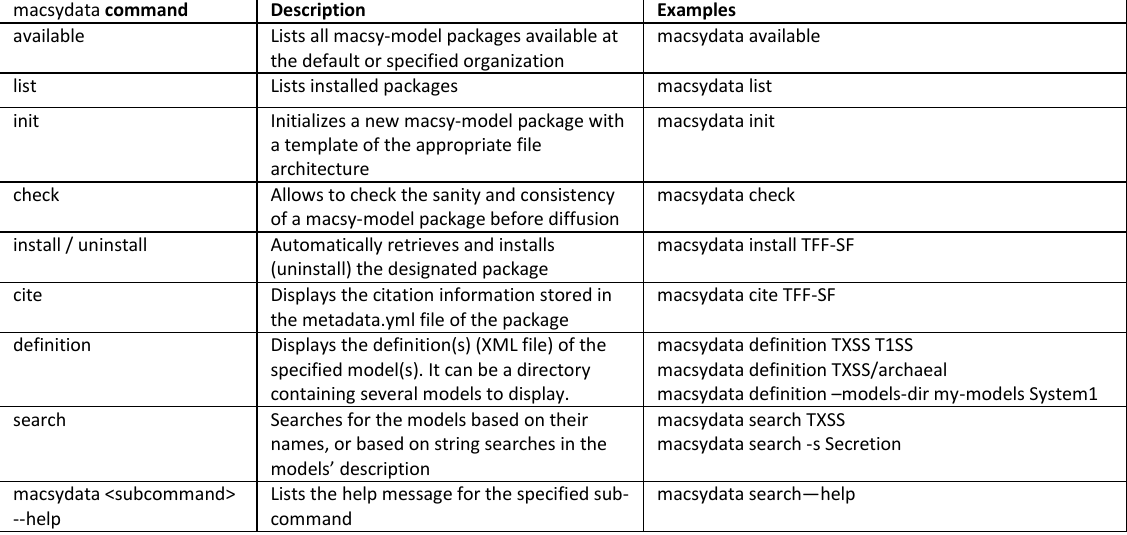
Table 2. The macsydata companion tool to handle macsy-model